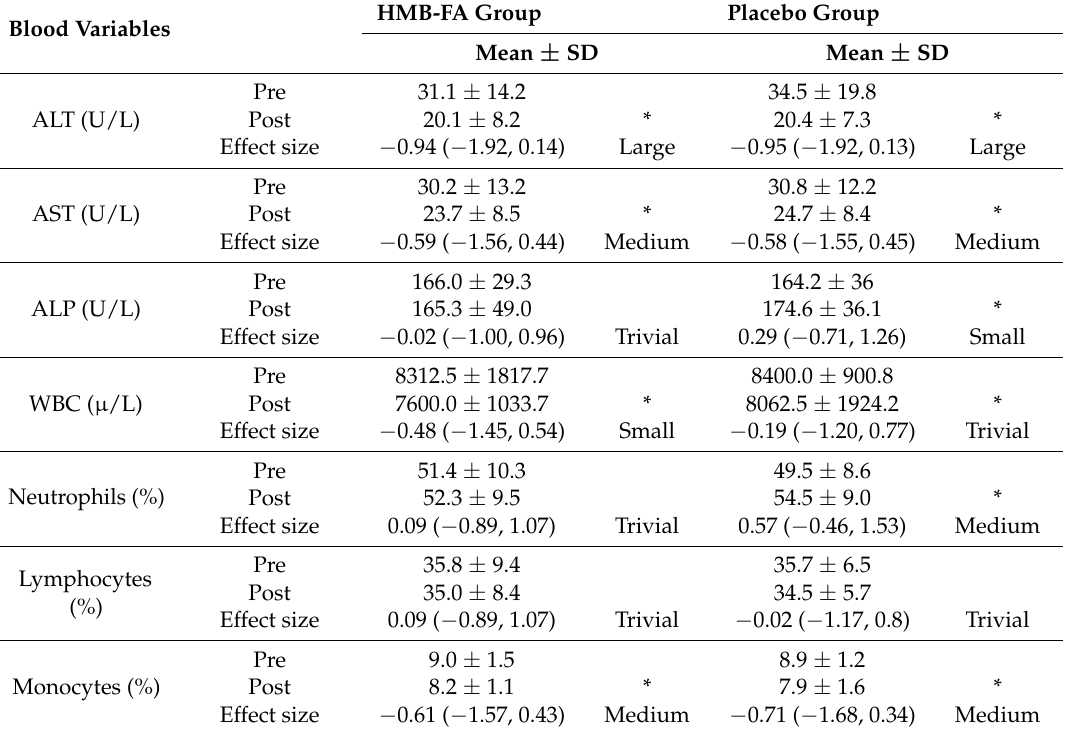
Table 2. Changes in biochemical variables following 6 weeks of a training